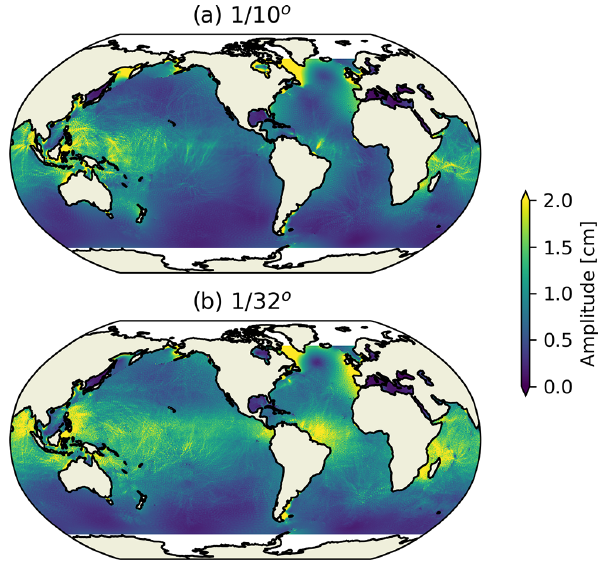
Figure 9. Incoherent tide amplitude of semi-diurnal tidal band of the 1 / 10 (a) and 1 / 32 ◦ (b)